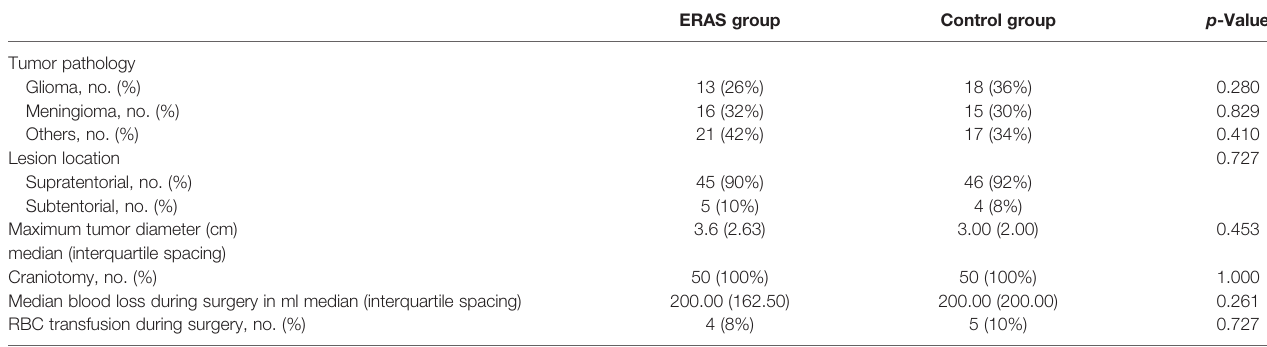
TABLE 2 | Summary of tumor and operation related